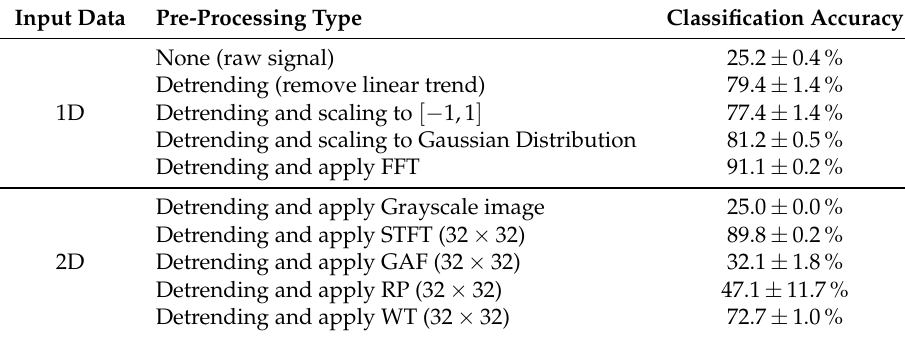
Table 2. Test data results of a 5-fold cross-validation for different pre-processing